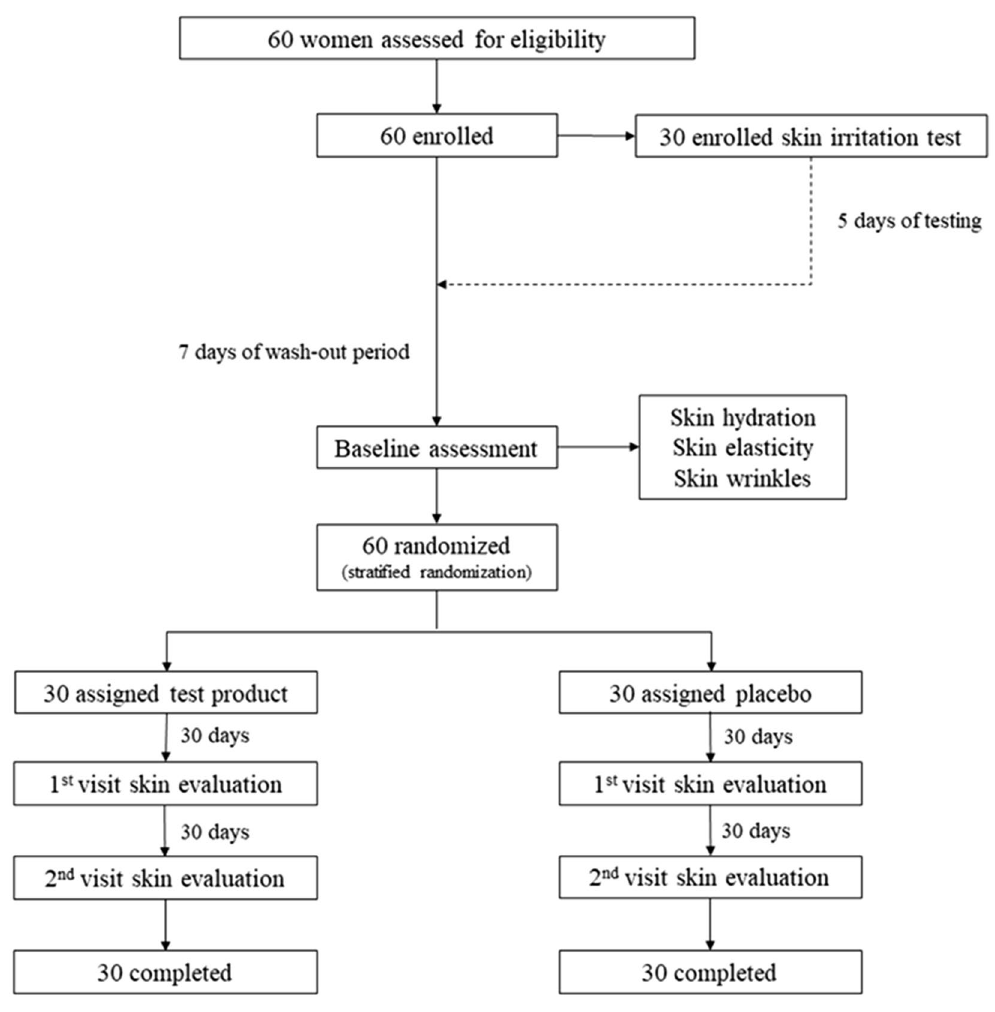
Figure 1. Overall process of the clinical